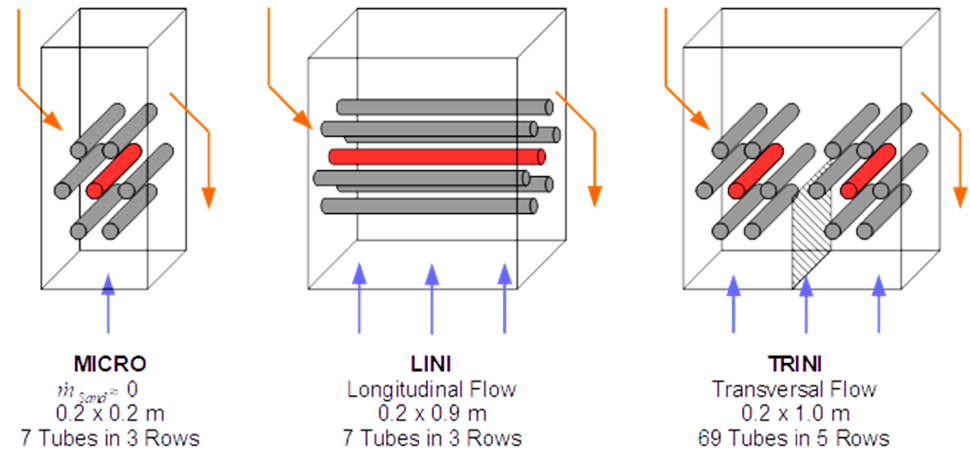
Figure 2. Schematic of the different test rigs used. Orange lines denote sand flow and blue lines